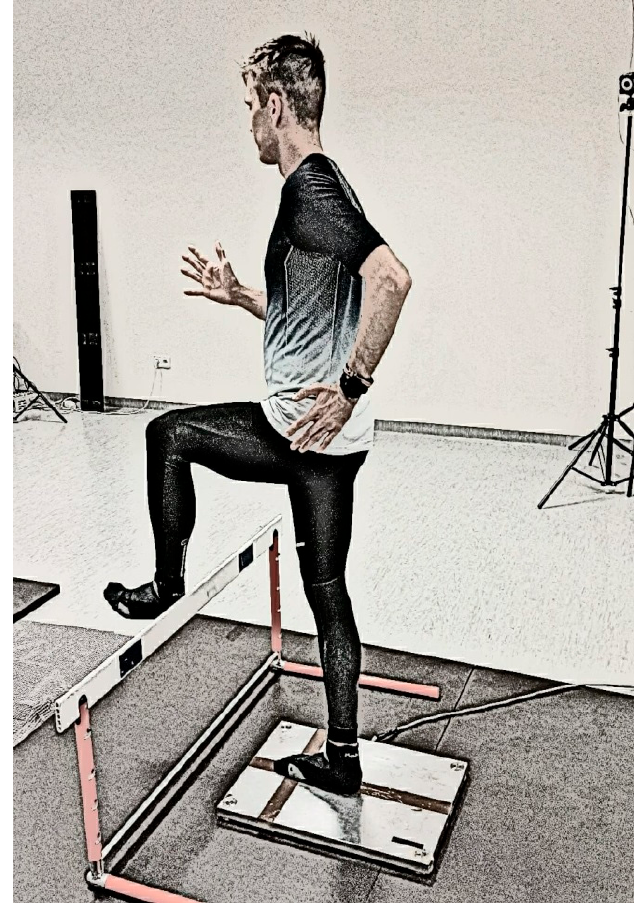
Figure 2. Hurdle attack—arms in classical (hurdle) position.